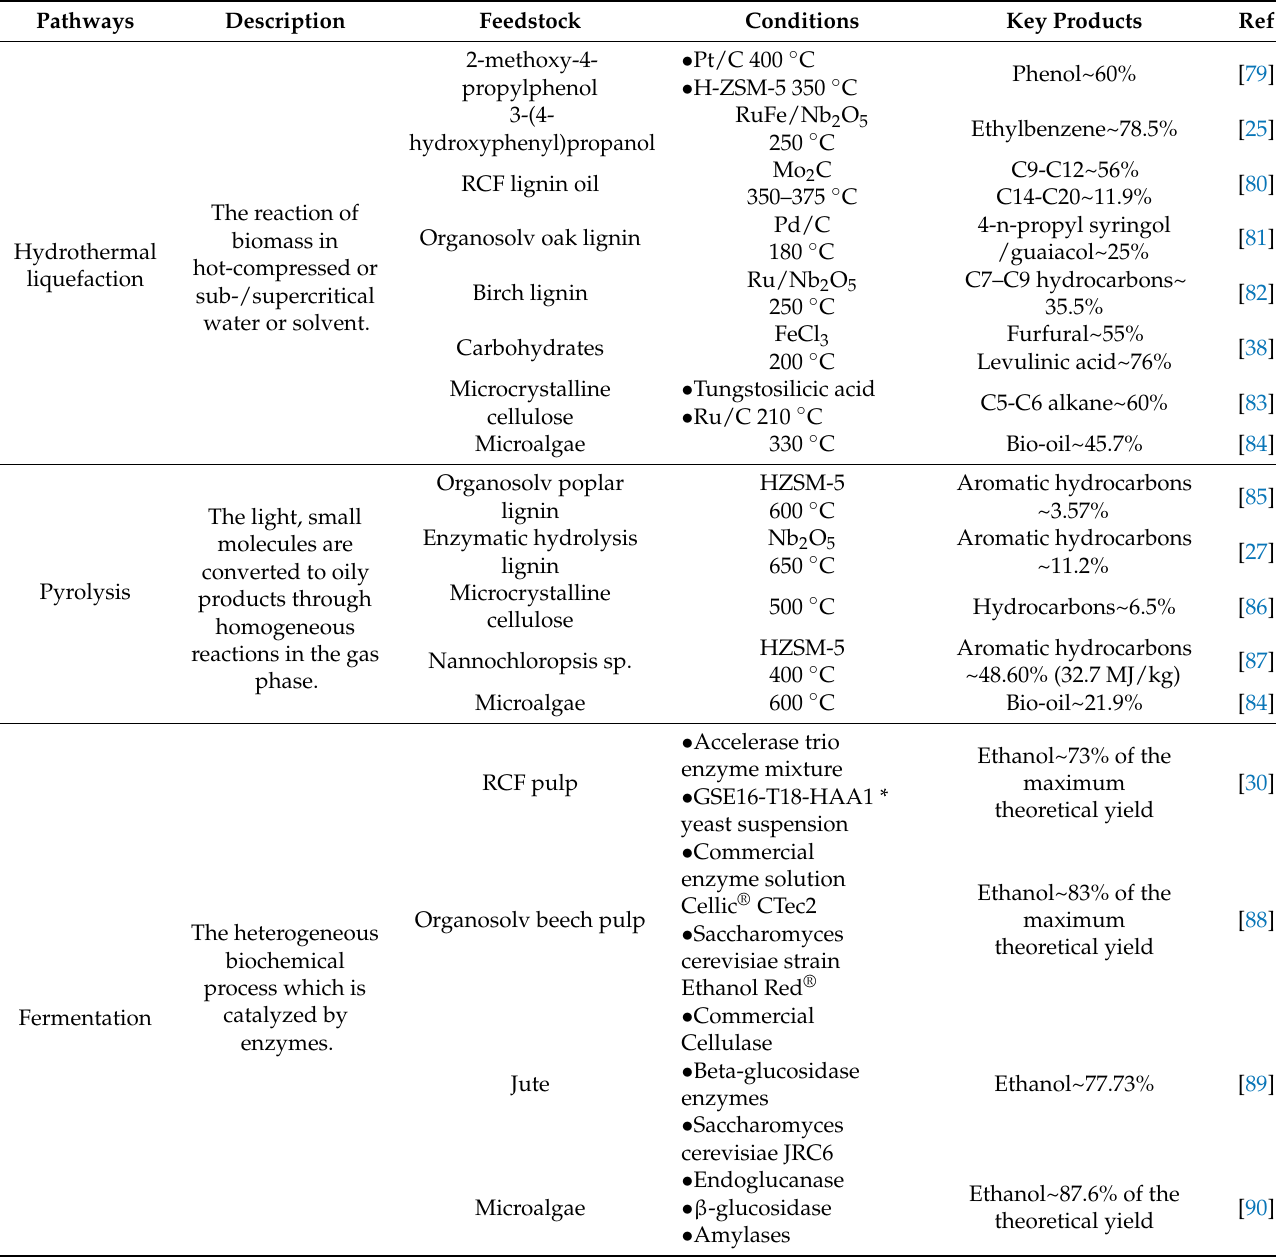
Table 4. Comparison of different technology